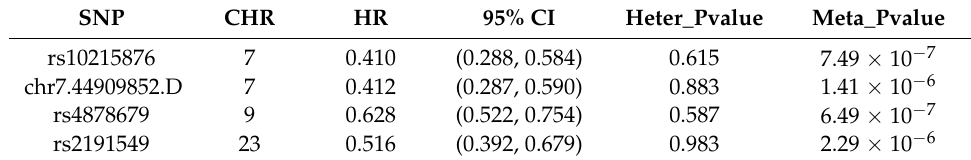
Table 4. Results of the meta-analysis.